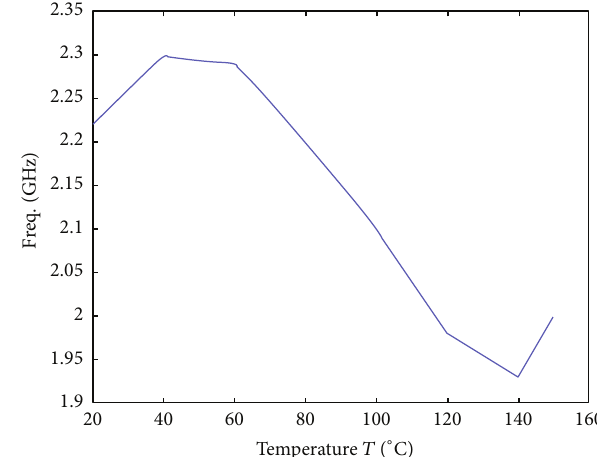
Figure 8: Variation of frequency versus the